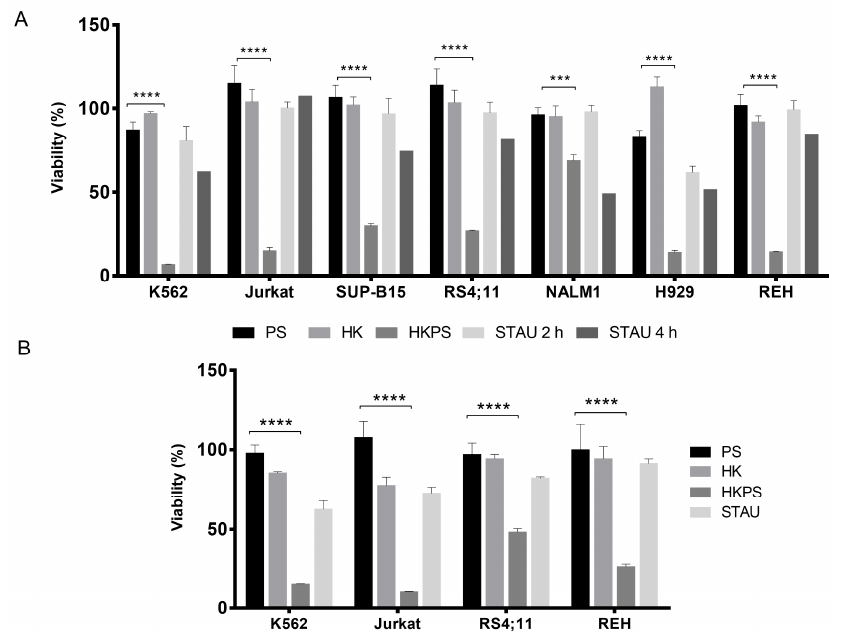
Figure 1. HKPS treatment induces a reduction in leukemic cells viability. ( A ) Leukemic cell lines K562 (CML) JURKAT (T-ALL), SUP-B15 (B-ALL), RS4;11 (B-ALL), NALM1 (CML), H929 (multiple myeloma) and REH (B-ALL), were treated with HKPS (40 µM), HK and PS control peptides (40 µM) STAU (2 µ M) for 2 and 4 h. The cell viability was assessed by MTT assay and graphed in relation to the for 2 h and STAU (2 µM) for 2 and 4 h. The cell viability was assessed by MTT assay and graphed in negative control (vehicle). ( B ) A lower (20 µ M) HKPS, PS and HK peptide concentration was relation to the negative control (vehicle). ( B ) A lower (20 µM) HKPS, PS and HK peptide concentration was used in the four different cell lines indicated; 2 µM STAU was used as control. Samples were processed in triplicates in three independent experiments. Data are expressed as mean ± SEM ( p values: two-way ANOVA*** p < 0.001, **** p < 0.0001)